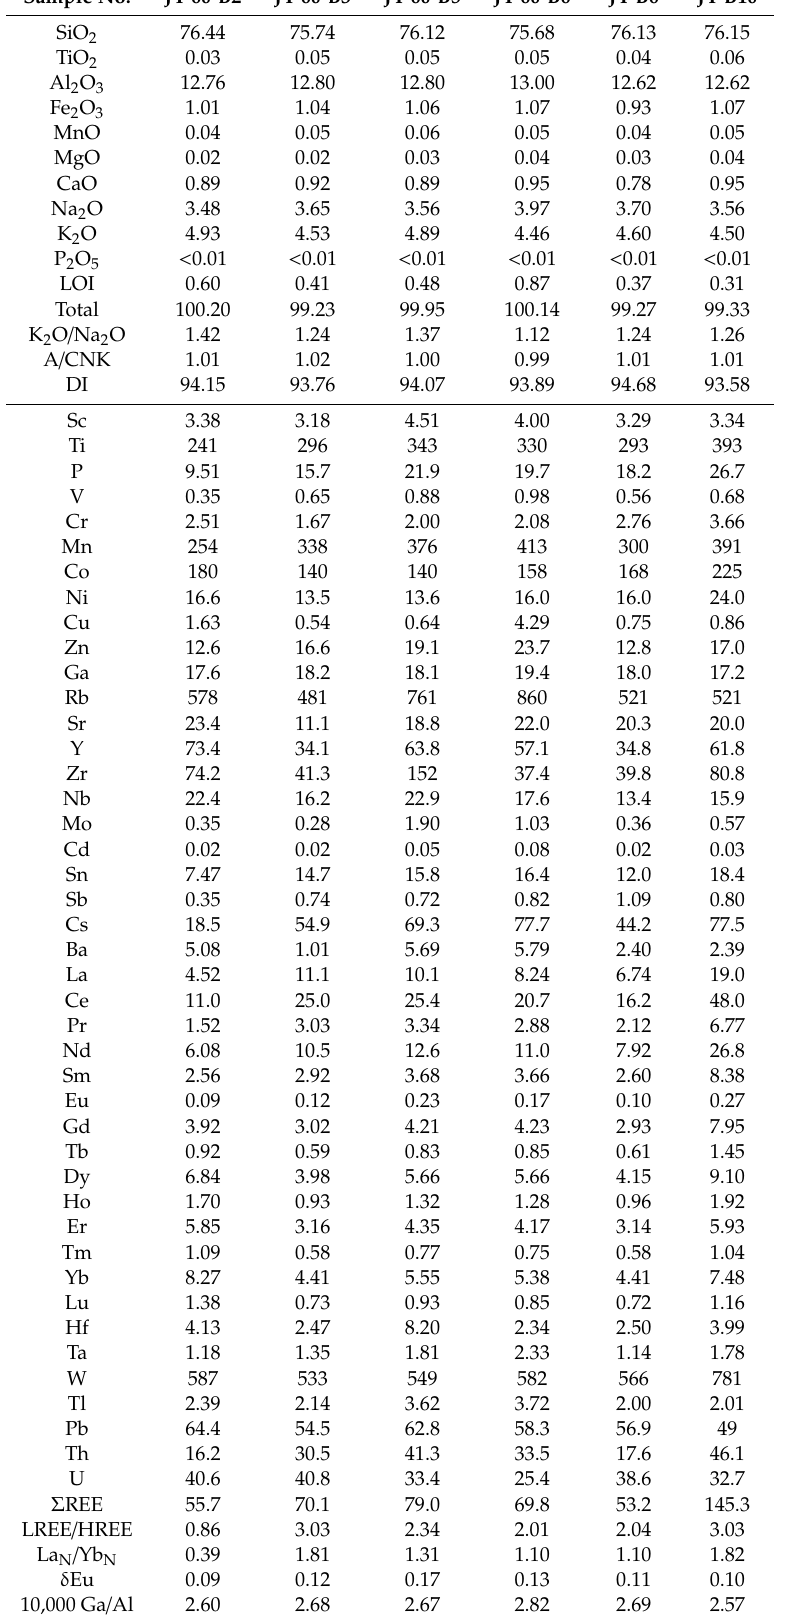
Table 1. Bulk rock major (wt.%) and trace (ppm) element compositions of Junye granites. Sample